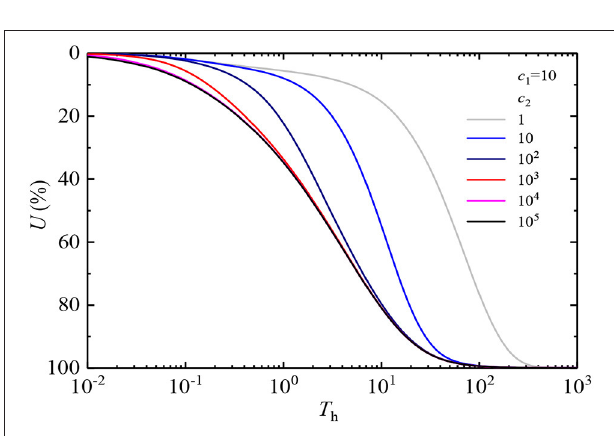
FIGURE 7 | Consolidation progress with different values of c 2